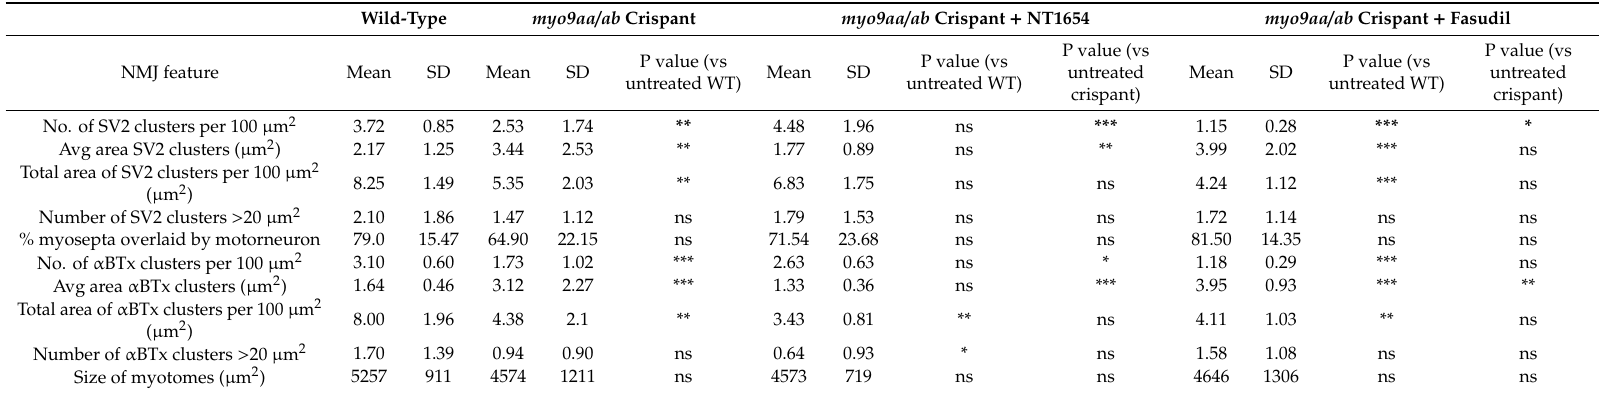
Table 2. NMJ morphology of myo9aa / ab crispant zebrafish at 48 hpf. A number of features of developing NMJs were characterised in wild-type ( n = 10 fish), myo9aa / ab crispant ( n = 11 fish), NT1654-treated (0.15 ng, n = 7 fish) crispant, and fasudil-treated (10 µ m, n = 10 fish) crispant fish, encompassing both pre- and postsynaptic regions. The mean value, standard deviation (SD), and p -value are shown for each measurement, with treated fish compared to untreated crispants and wild-type zebrafish. Number of SV2 clusters > 20 µ m 2 , % myosepta overlaid by motor neuron, and size of myotomes = One-way ANOVA. Number of SV2 / α BTx clusters and total area per 100 µ m 2 , and average size of SV2 / α BTx clusters = Kruskal-Wallis